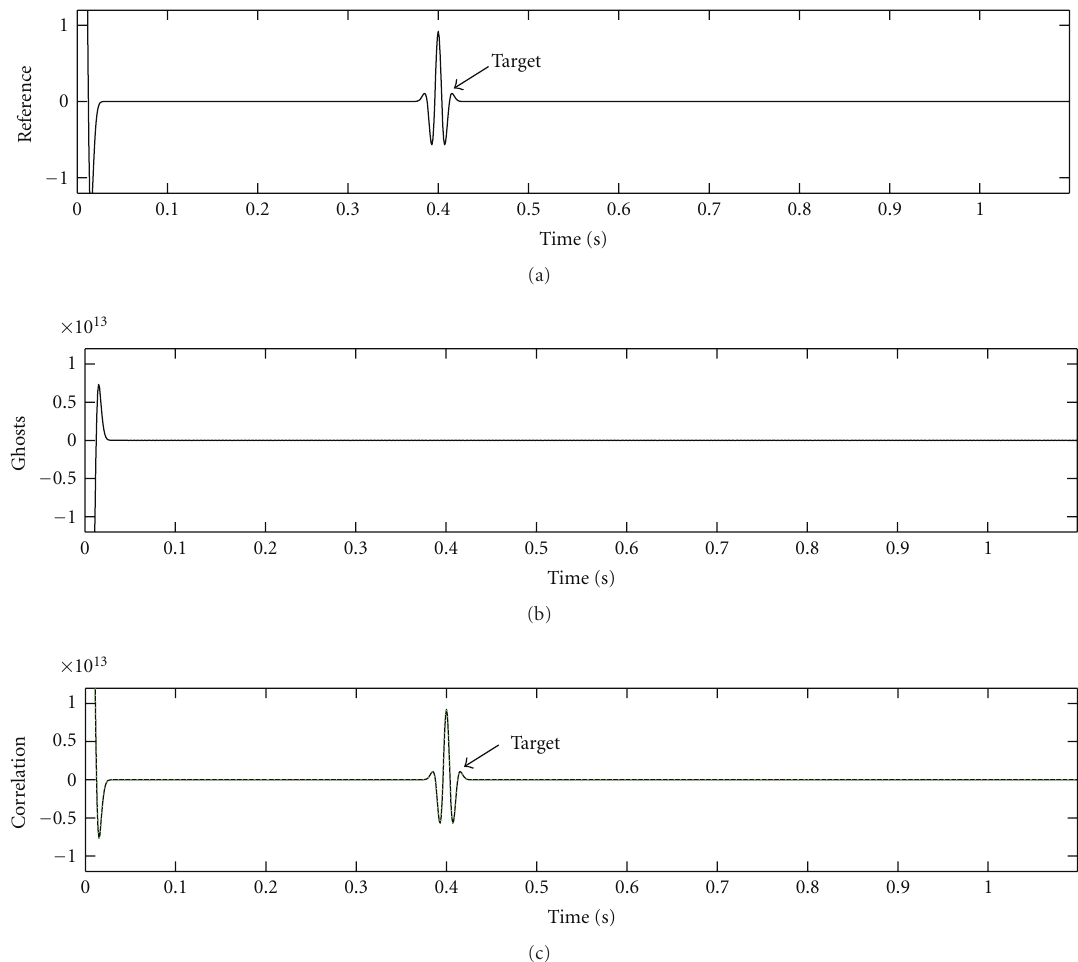
Figure 4: Cross-correlation of full fields for model A: (a) reference response by placing an active source at the virtual source location x A ; (b) computed ghost terms g S + g O ; (c) causal part of the correlation function C (black) and the sum of reference response + ghosts (dashed